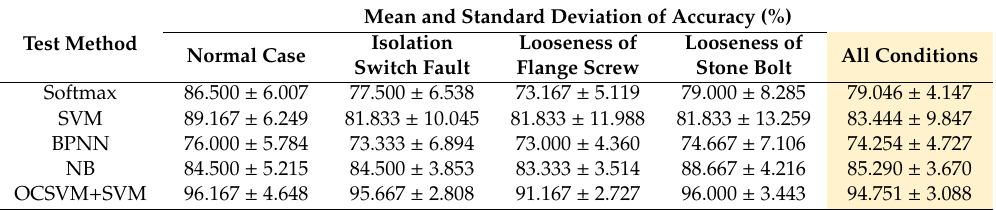
Figure 14. Comparison of diagnosis mean values under different working conditions. Table 6. Diagnosis results (average and standard deviation).